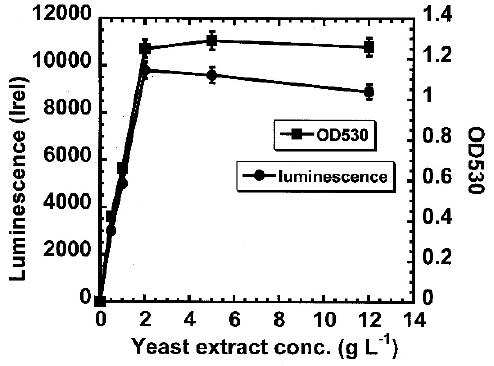
Figure 4. Luminescence and final OD530 at different yeast extract concentrations.